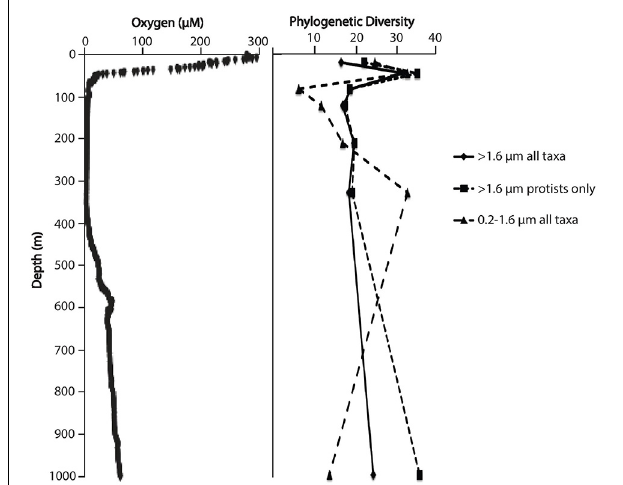
Table 1 | 18S rRNA gene amplicon sequencing